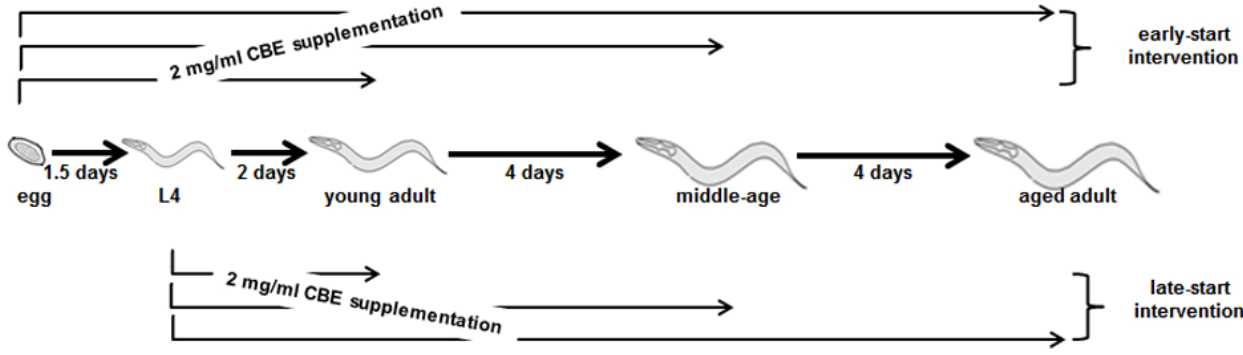
Figure 1. A scheme of the early-start intervention and late-start intervention.